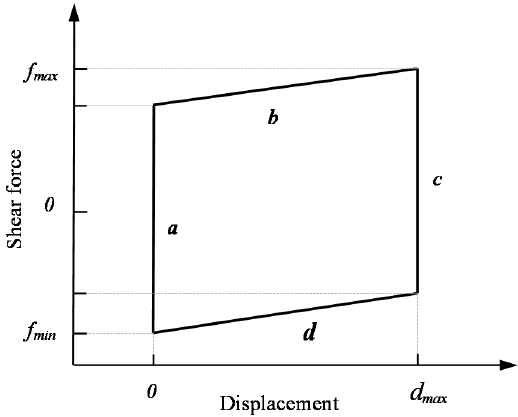
Figure 7. Mechanical model of the hysteric loops for the N-IMB and IMB joints.